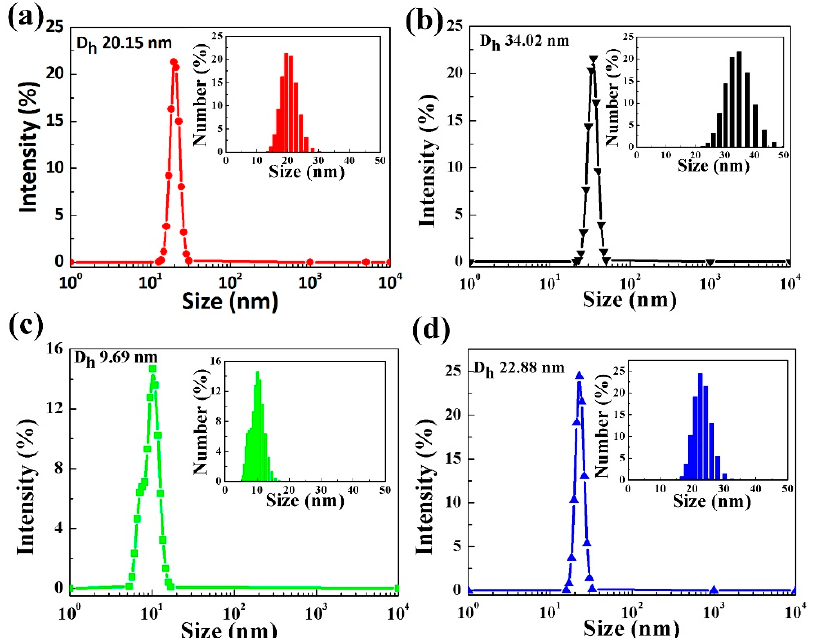
Figure 5. Size distribution of ZnO NPs determined in different solvents by DLS with ( a ) 2-Methoxyethanol, ( b ) methanol, ( c ) butanol, and ( d ) ethanol.